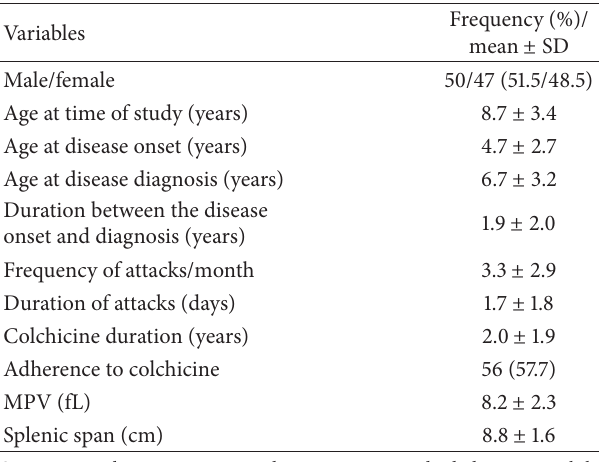
Table 1: Characteristics of studied FMF patients ( 𝑛 = 97 ).